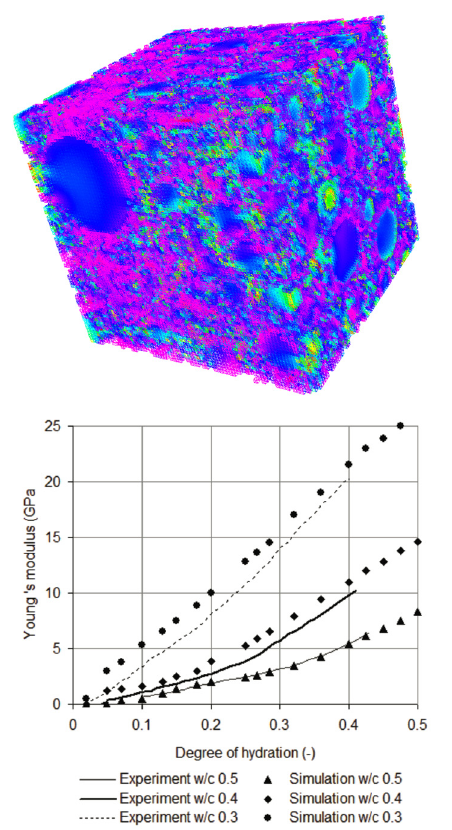
Figure 5. The distribution of strain on a cement microstructure upon the application of a uniform stress [Cyrille Dunant, personal communication] (top) and a comparison of simulated elastic modulus of cement pastes with experimentally measured values at various water to cement ratios [69] (bottom).